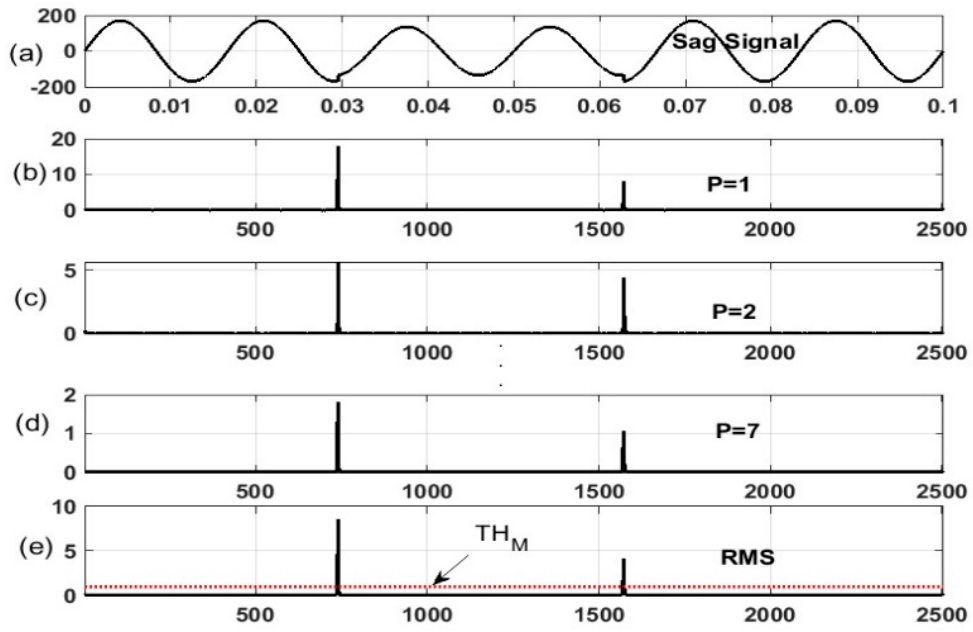
Figure 6. Snapshots of WPTM-based detection using RMS: ( a ) voltage sag signal with 80% pu after denoising, ( b ) wavelet packet W 1 , ( c ) W 2 , ( d ) W 7 , ( e ) result of RMS